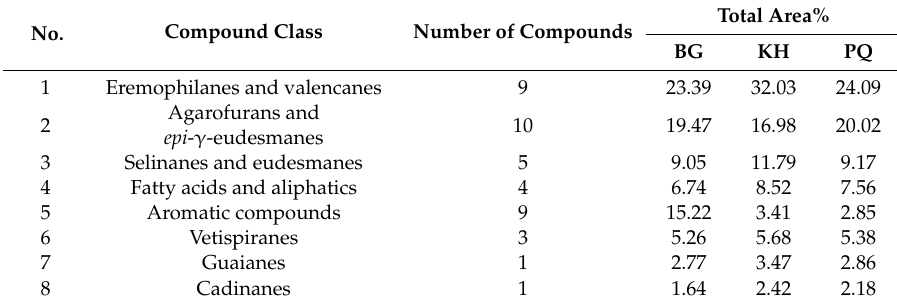
Table 2. Structural profiles of the constituents of essential oils obtained from Bac Giang (BG), Khanh Hoa (KH), and Phu Quoc (PQ) agarwood